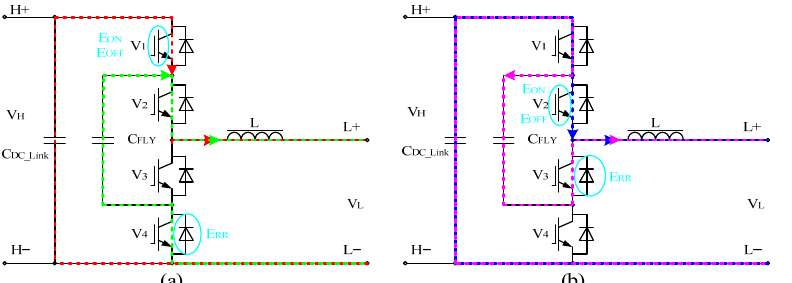
Figure 3. Commutation paths of FC ‐ 3L ‐ BDC. ( a ) Buck mode, D < 0.5 (V 1 switching). ( b ) Buck mode, D < 0.5 (V 2 switching).